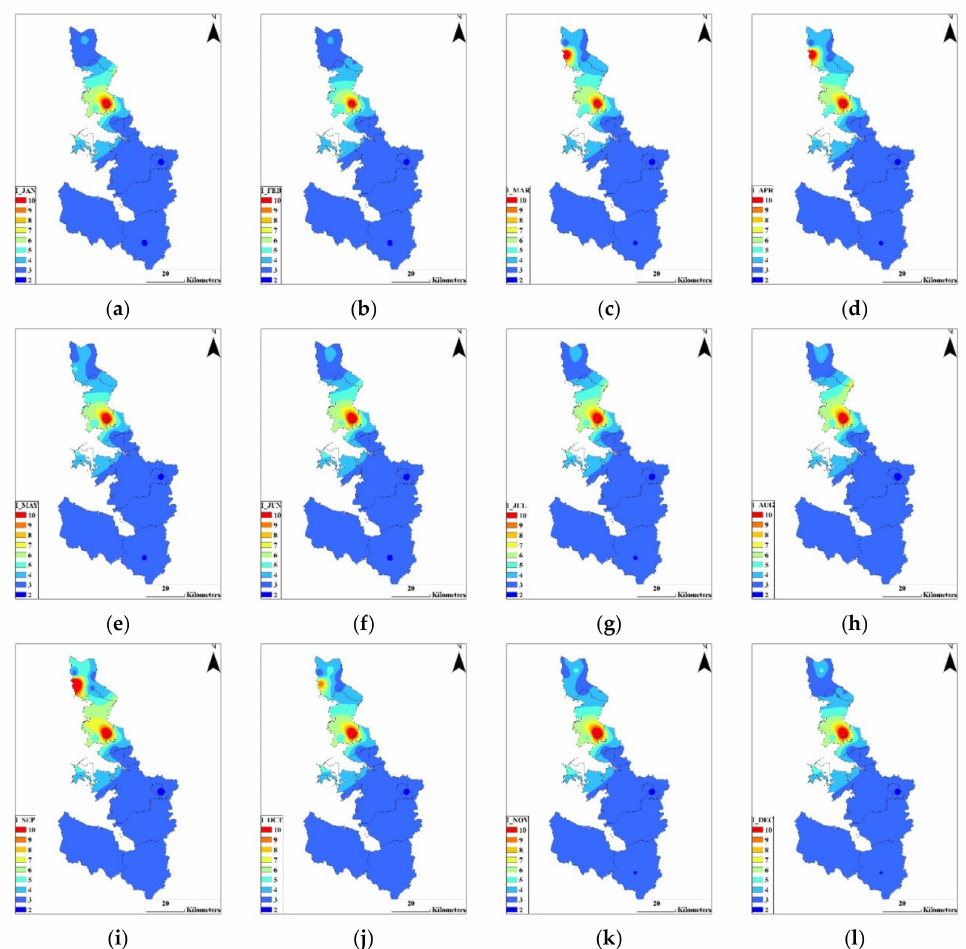
Figure 8. Thematic maps of the dynamic parameter’s rating for 10-year-averaged monthly impact of existing status of seawater intrusion (I). ( a ) JAN; ( b ) FEB; ( c ) MAR; ( d ) APR;( e ) MAY;( f ) JUN; ( g ) JUL; ( h ) AUG; ( i ) SEP; ( j ) OCT; ( k ) NOV; ( l ) DEC.